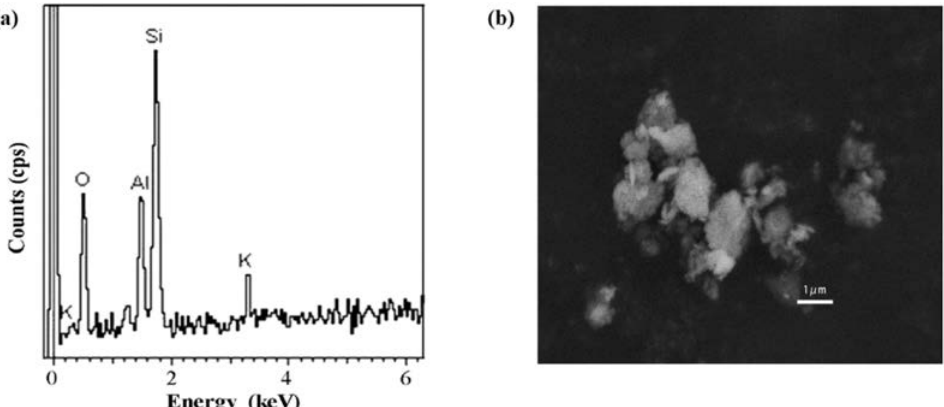
Figure A2. The temperature freezing dependency of distilled water droplets of 1 μL.